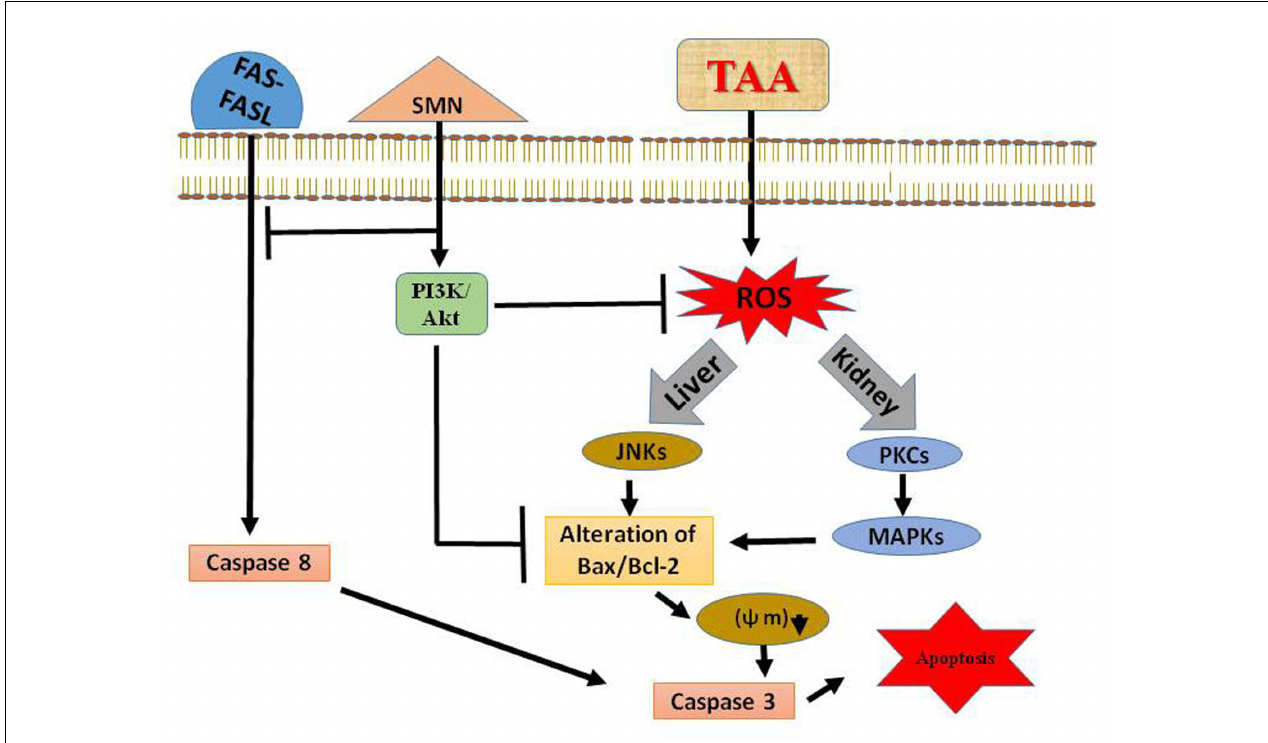
FIGURE 8 | Schematic diagram of the TAA induced hepatic as well as renal toxicity and its prevention by SMN.